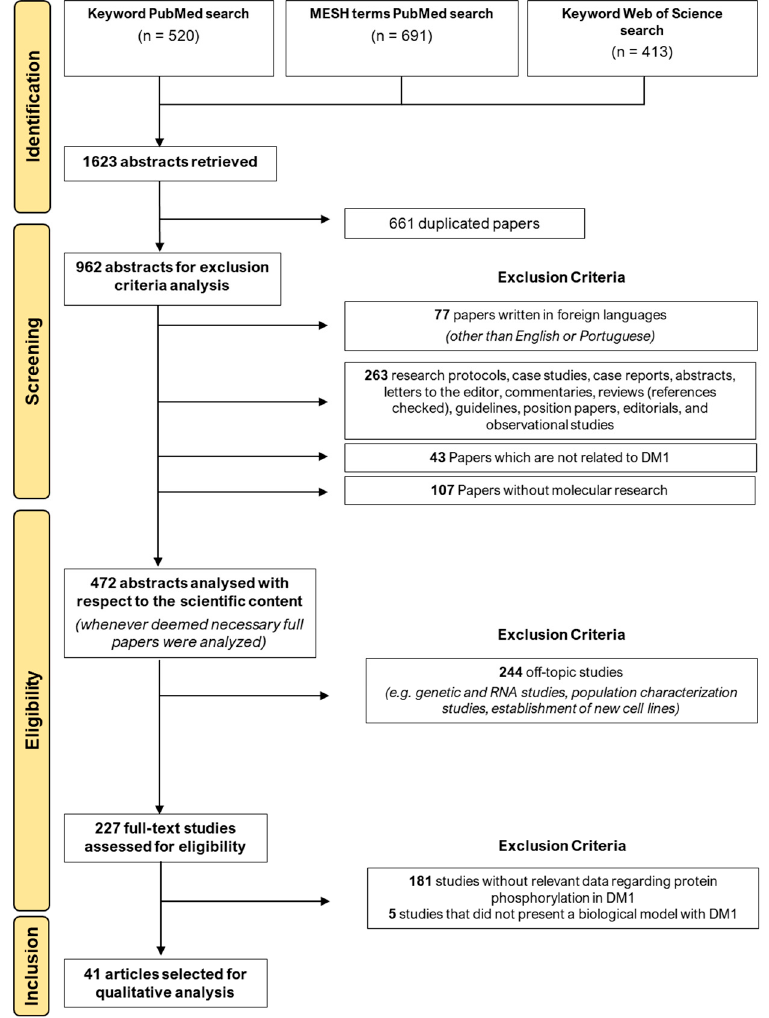
Figure 1. PRISMA flow diagram from the results of the systematic search strategy and study selec- tion.